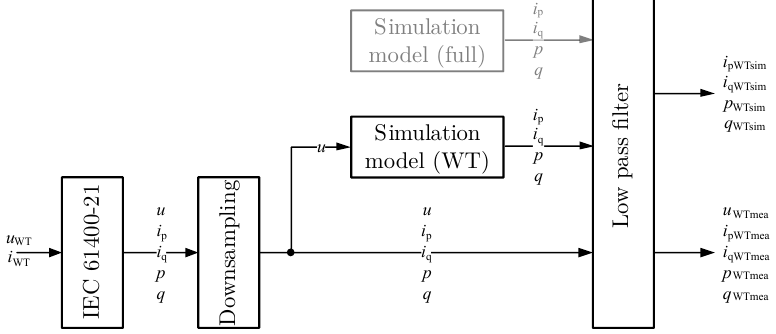
Figure 3. Methodology to compare simulation results for validation purposes according to the IEC 61400-27 guidelines: full grid simulation (in grey) and playback